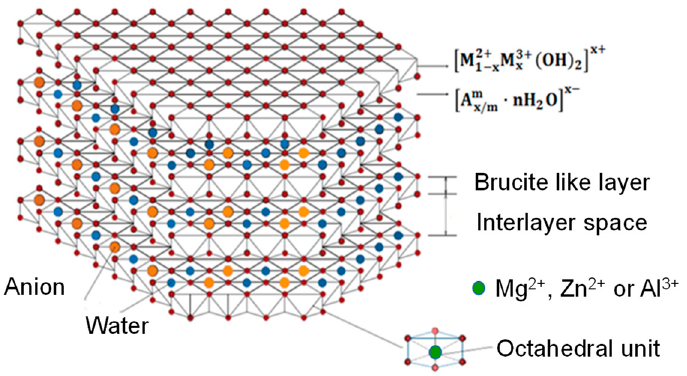
Figure 1. Scheme of the LDH structure.